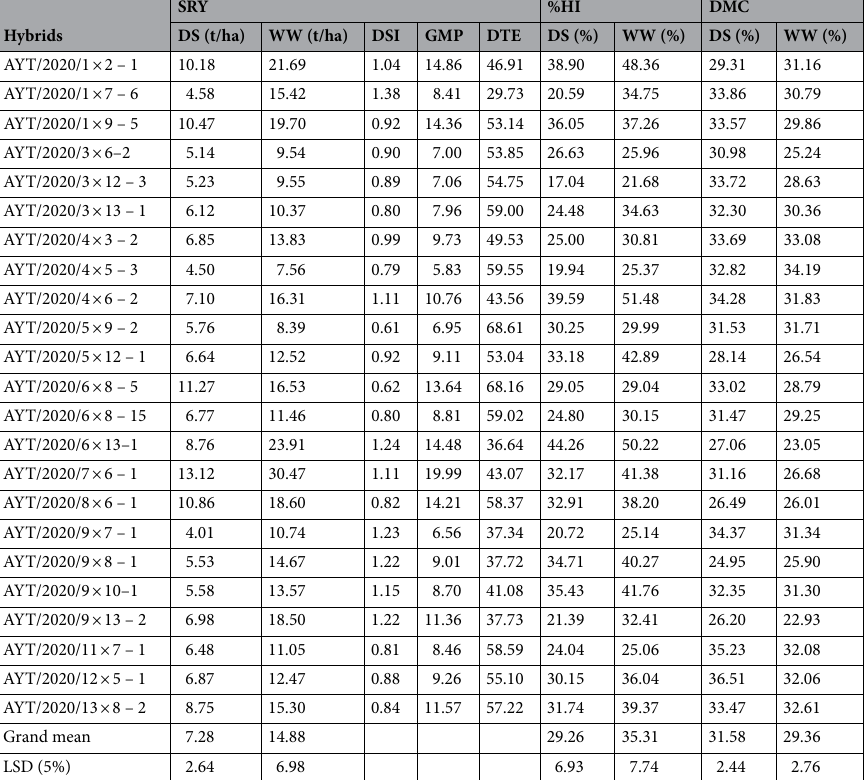
Table 4. Storage yield root and its drought susceptible index, geometric mean productivity and drought tolerant expression as well as harvest index and root dry matter content under both water regimes. AYT advanced yield trial, SRY storage root yield, HI harvest index, DMC dry matter content, DS drought stress, WW well-watered, DSI drought susceptibility index, GMP geometric mean productivity, DTE drought tolerant